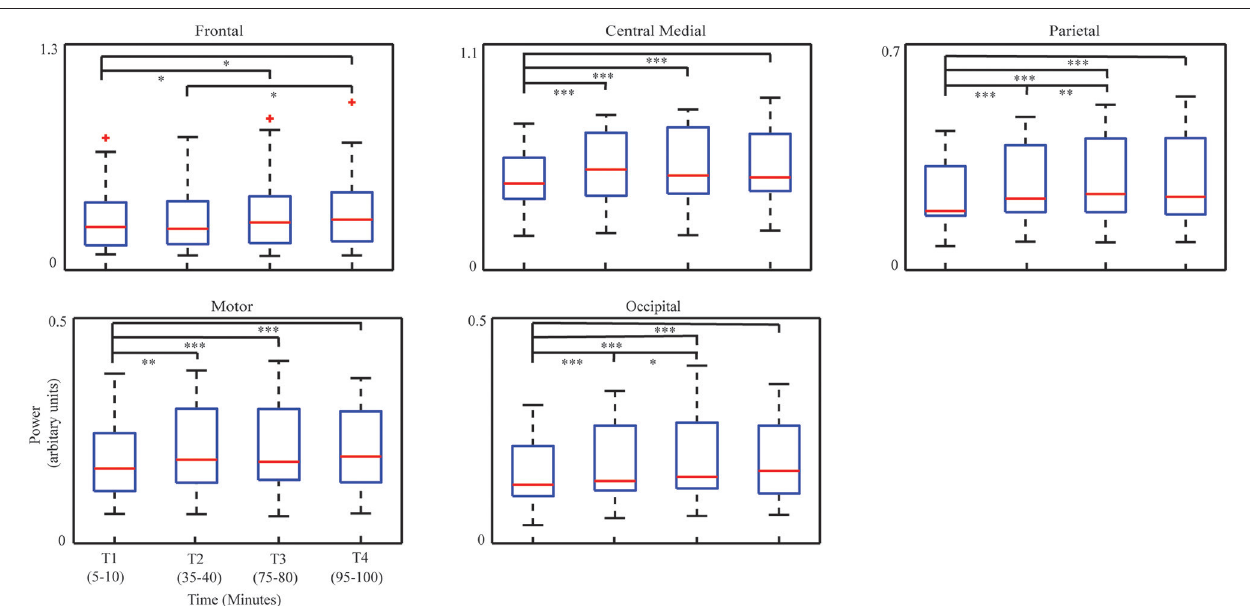
FIGURE 4 | Whisker plots of averaged IC powers at corresponding dominant freqency bands in four time periods. Median: red central mark; 25th and 75th percentiles: lower and upper edges of the box, respectively; maximum whisker length: 1.5, and the outliers: red cross. * p < 0.05, ** p < 0.01, and *** p <